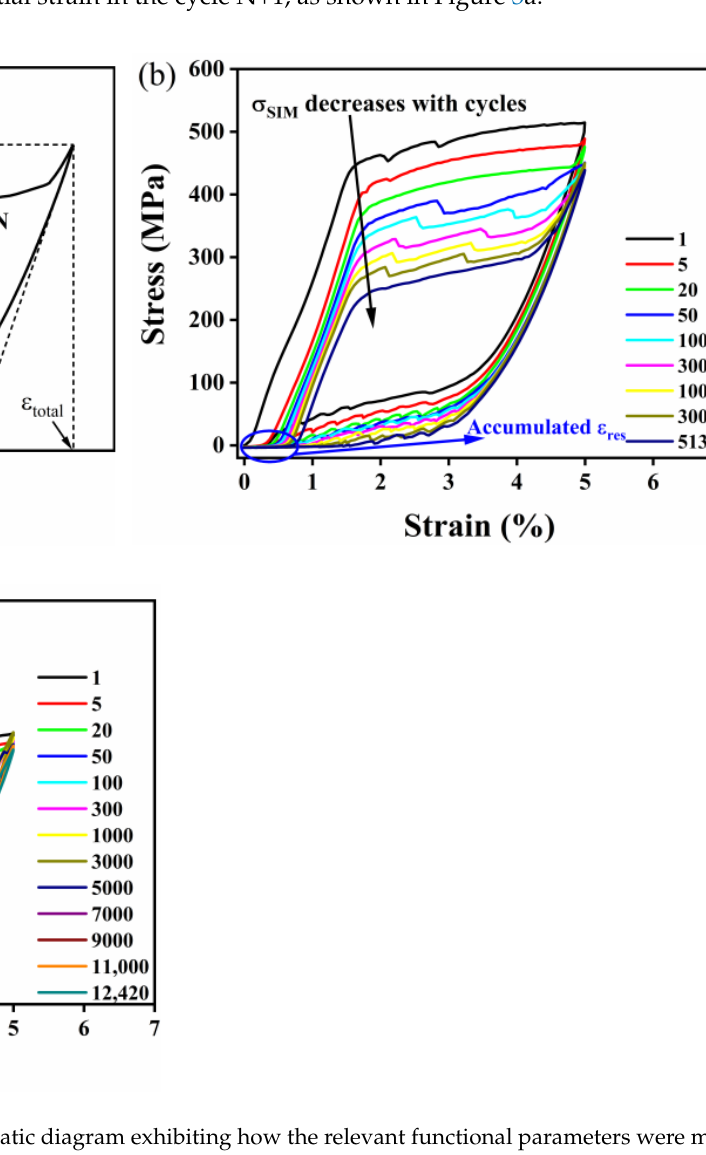
Figure 3. ( a ) Schematic diagram exhibiting how the relevant functional parameters were measured from the obtained stress–strain curves. The macroscopic stress–strain curves of nanocrystalline (NC) NiTi wires during fatigue tests until fracture: ( b ) as-received sample, and ( c ) trained